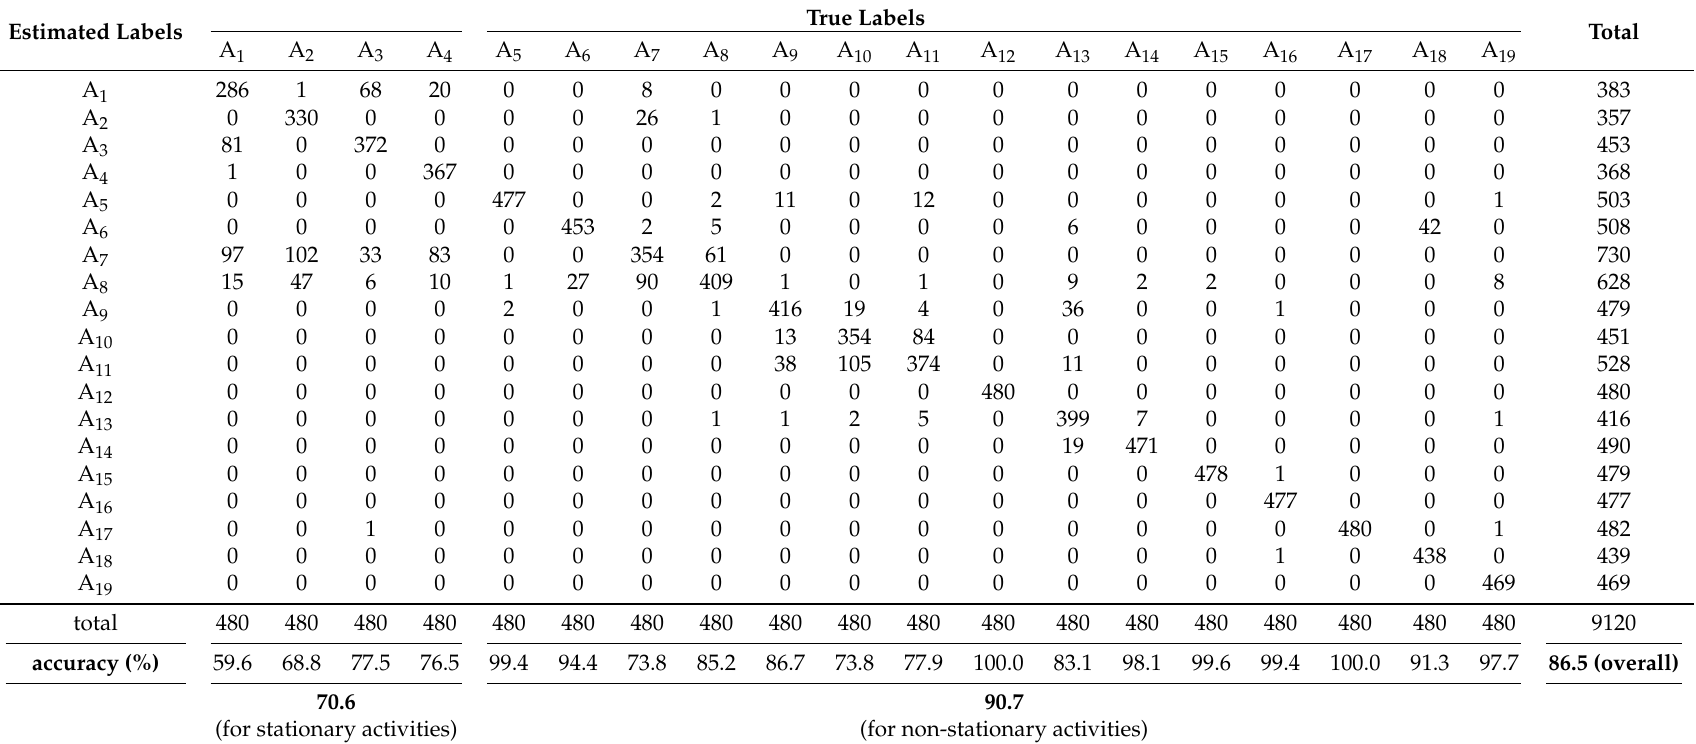
Table 1. Confusion matrix of the SVM classifier for the proposed method over all